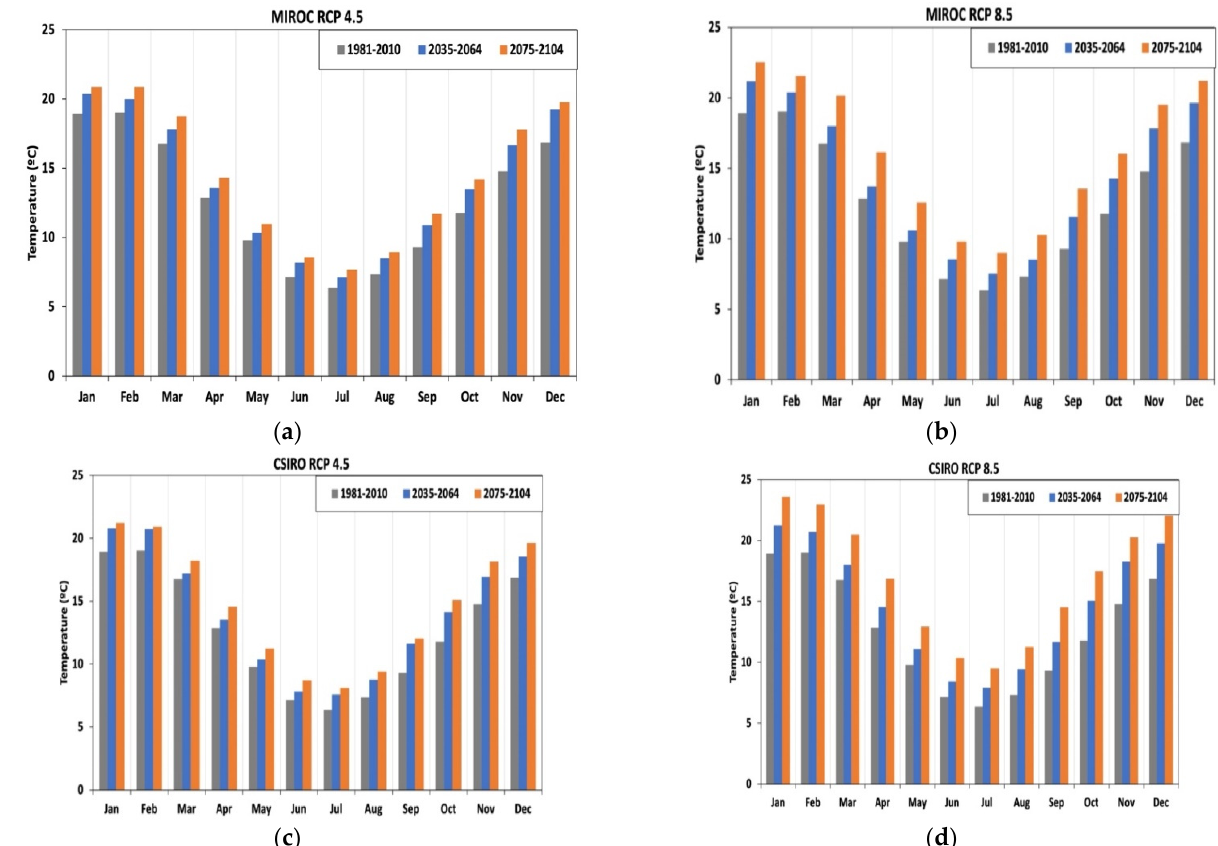
Figure 5. Observed and projected monthly average temperatures: ( a ) MIROC-RCP4.5 model; ( b ) MIROC-RCP8.5 model; ( c ) CSIRO-RCP4.5 model; ( d ) CSIRO-RCP8.5 model.